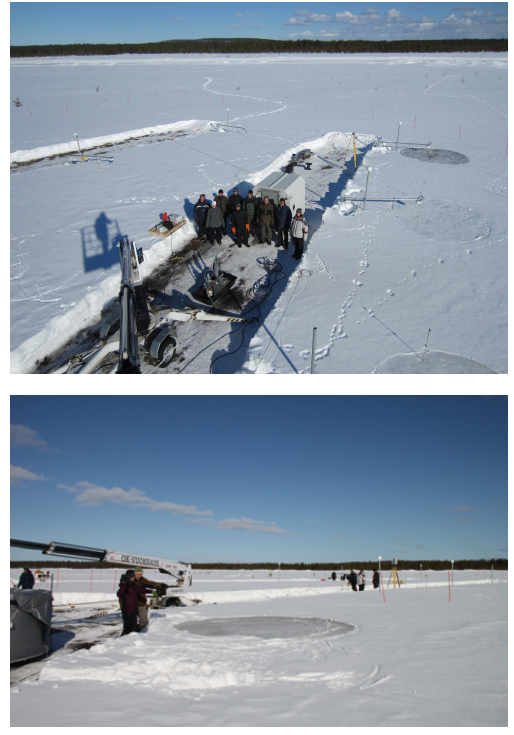
Figure 8. The SoS experiment system at Sodankylä Airport. Top photo by Rae Ellen